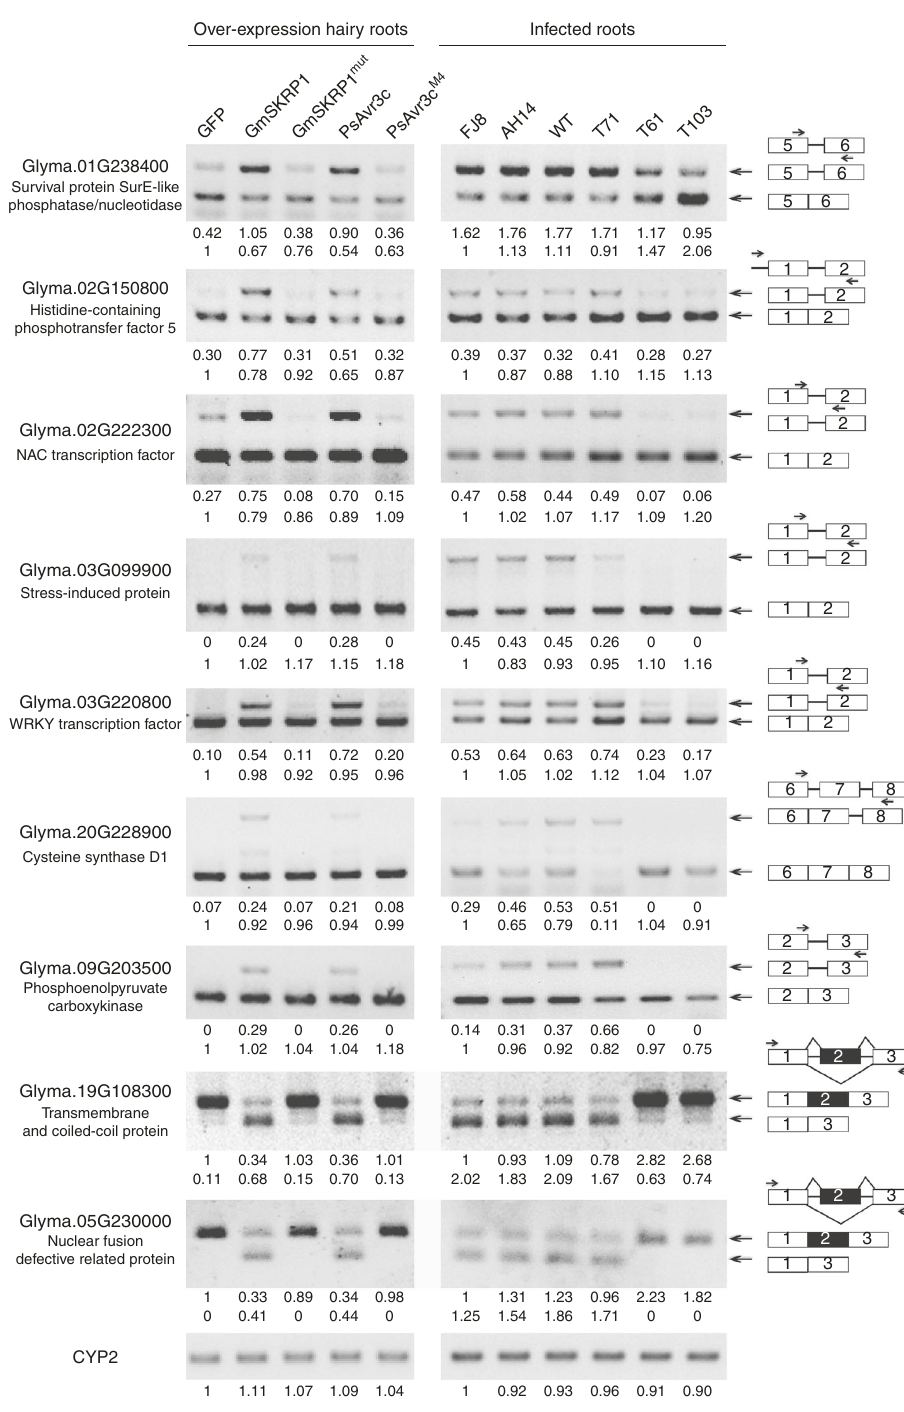
Fig. 7 Validation of expression and alternative splicing of selected genes. The changes in splice isoforms of nine selected genes was validated by RT-PCR with primers speci fi c to each isoform. An equal amount of cDNA template in each reaction was veri fi ed by amplifying soybean actin gene CYP2, and then PCR reaction with primers speci fi c to each AS isoform was conducted (Primers were listed in Supplementary Table 1). The intensities of each product were quanti fi ed by ImageJ software, and the relative abundance was calculated by using bottom (or top) bands in the left electrophoresis line as reference (set to 1). Numbers below the PCR bands indicate relative abundances of different isoforms. Schematic diagrams on the right side illustrate the AS isoforms of each gene and the arrows highlight the primers used in RT-PCR. The P . sojae strains FJ8 and AH14 are fi eld isolates and carry the avirulent allele of PsAvr3c . Other transformants refers to the Fig.